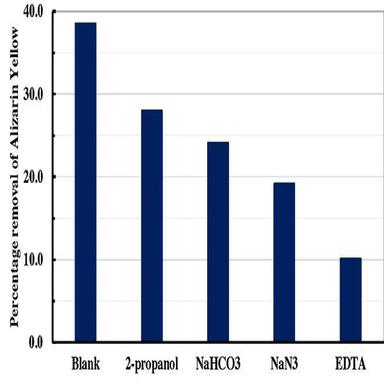
Photocatalytic degradation of Alizarin Yellow in presence of several scavengers using the nanocomposite Au0 (NPs)/TiO2(T) thin film.